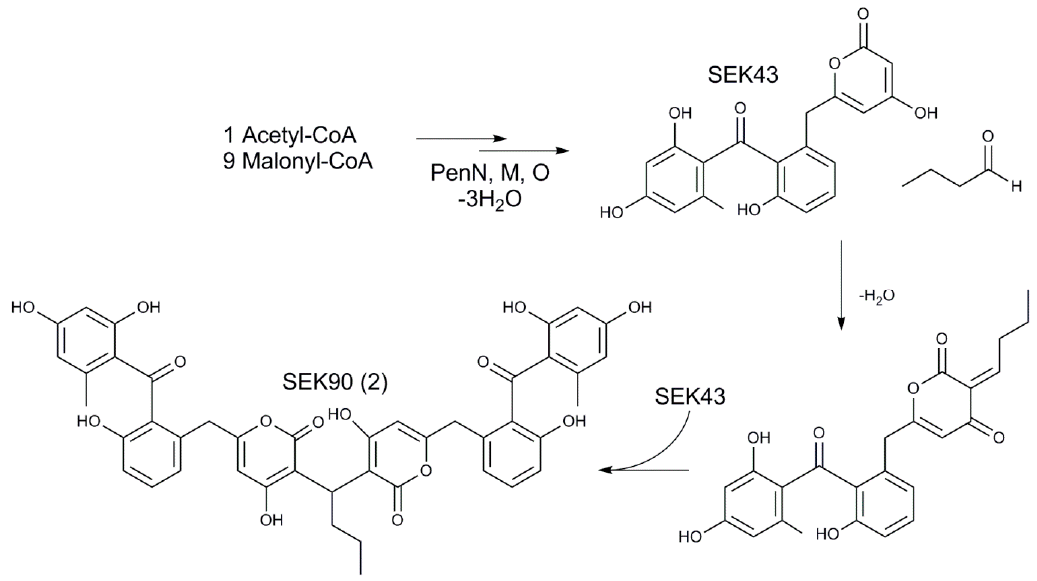
Figure 5. Origin of SEK90.